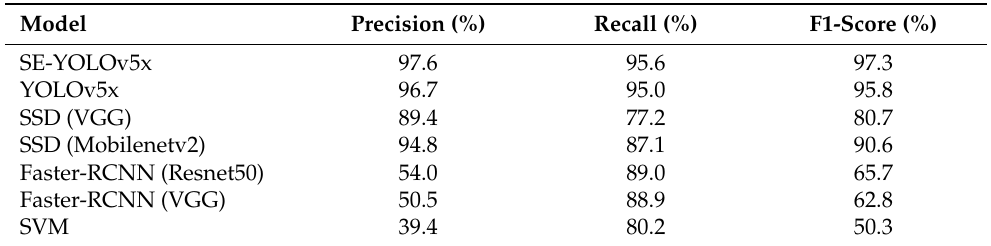
Table 3. Training results of the SVM and different deep learning models for crop/weed identification.